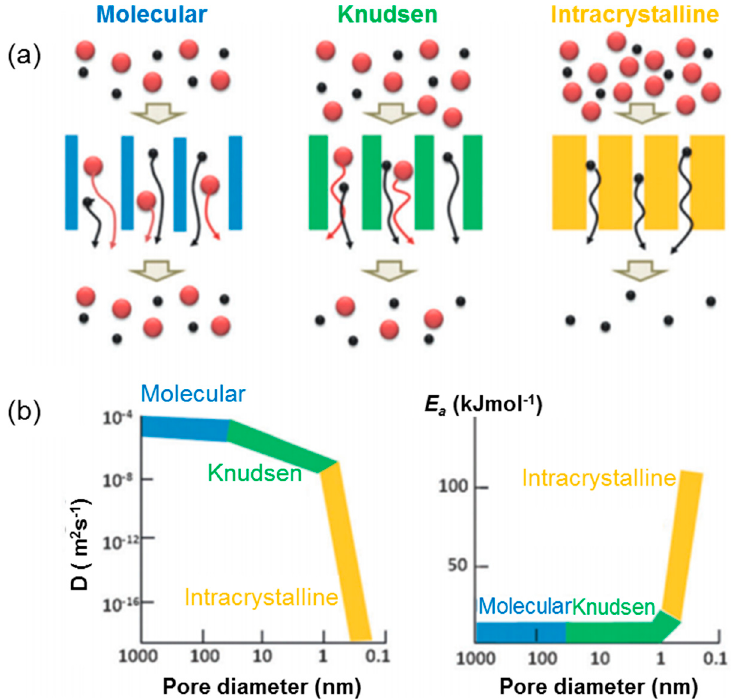
Figure 1. ( a ) Effect of pore sizes on the diffusion of large (red) and small (black) molecules within macropores (in blue, left), mesopores (in green, middle) and micropores (in yellow, right); ( b ) Effect of pore diameter on molecular diffusivity (D, left) and energy of activation (E a , right) in different diffusion regimes. Reproduced with permission from [8]. Copyright Royal Society of Chemistry, 2016.